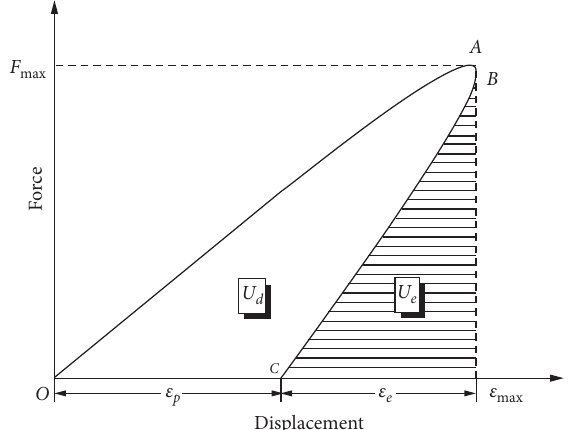
Figure 6: Energy dissipation characteristics of single.